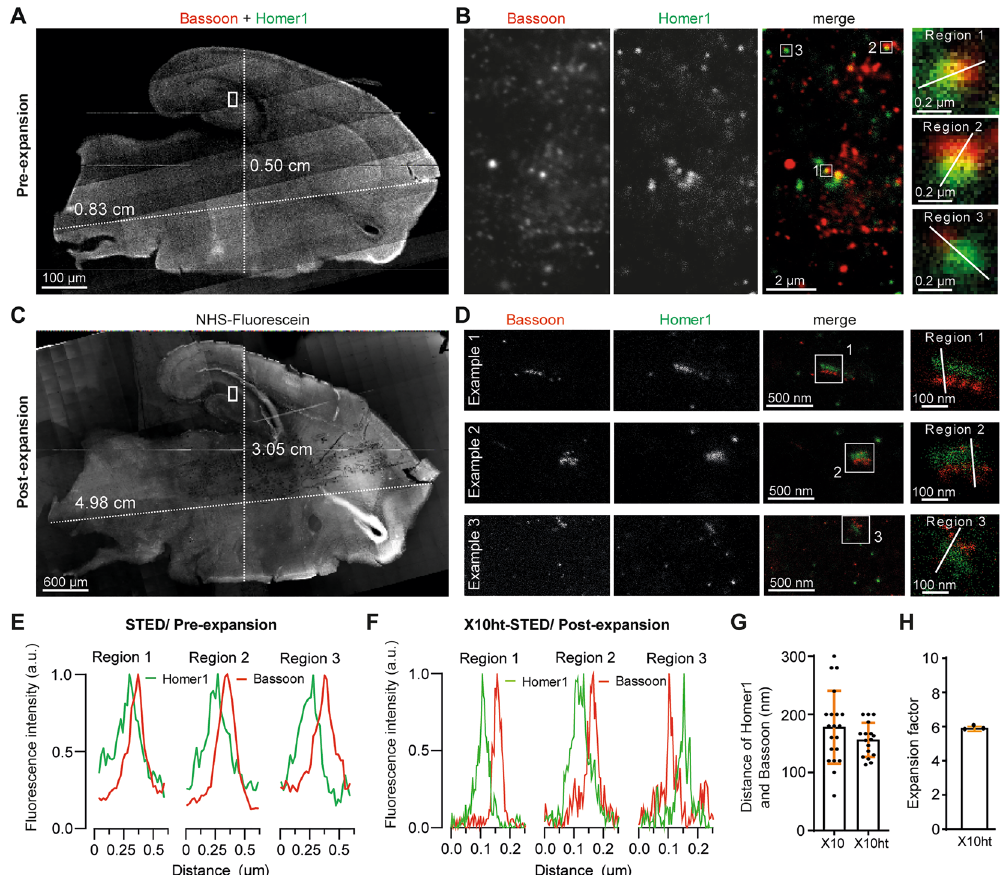
Figure 3. X10ht of 200 µm thick rat brain slices immunostained for the synaptic proteins Bassoon and Homer. ( A ) Epifluorescence tile image of merged channels displays a non-expanded 200 µm thick rat brain slice, containing the region of the hippocampal formation. ( B ) STED images of regions of the hippocampal formation (identified with white rectangles in A) show Bassoon (red) and Homer1 (green) in not expanded tissue. Zoom depict the marked regions (1–3). ( E ) Plots of the line scans over the zoomed areas. ( C ) Epifluorescence tile acquisition of the same brain slice after expansion labeled with NHS-Fluorescein, depicting the retention of tissue shape and the prolongation of the slice length from 0.83 to 4.98 cm and width from 0.5 to 3.05 cm. ( D ) Representative STED images of different regions from the C1 region of the hippocampus, showing highly resolved pre- (red) and postsynaptic (green) compartments. ( F ) The respective line scans are plotted, and the distance between the pre- and postsynaptic compartments is analyzed in ( G ). N = 20 ROI from two stained rat brain slices for not expanded STED; N = 17 ROI from 2 independent STED-X10ht experiments. ( H ) The graph shows an expansion factor of 6 with N = 3 independent